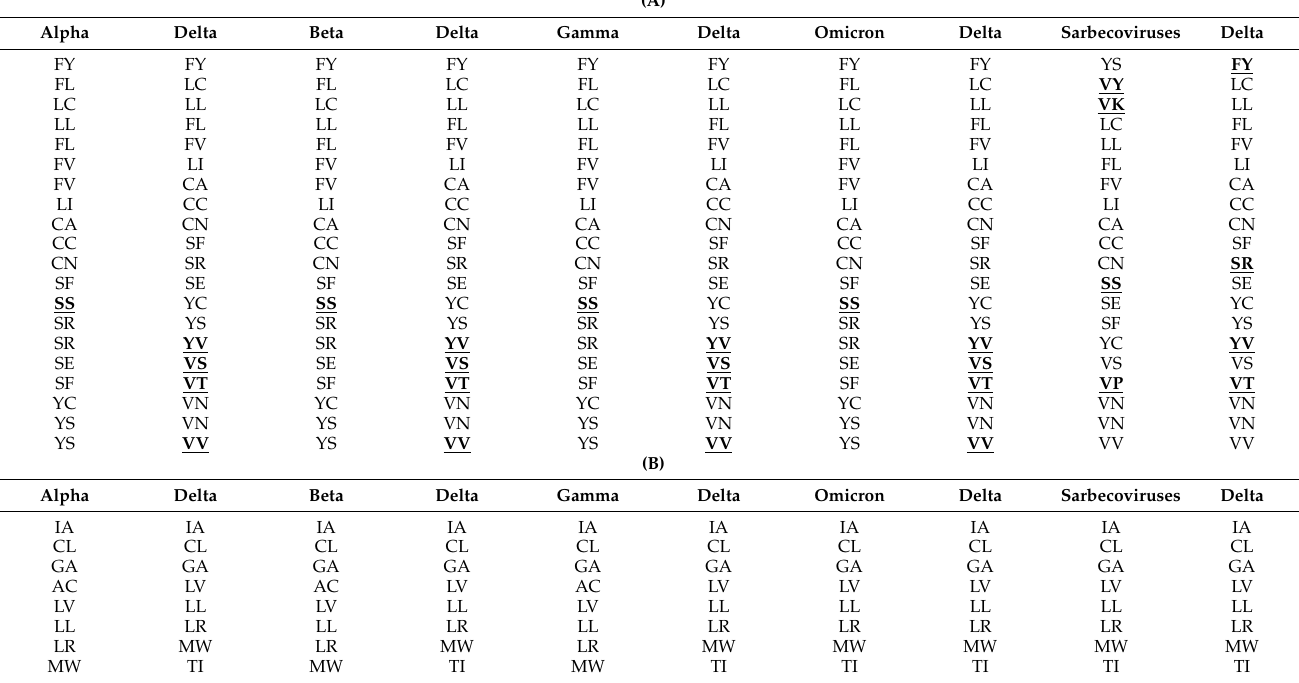
Table 5. (A) Comparison of the E gene of the delta strain with other strains. (B) Comparison of the M gene of the delta strain with other strains. (C) Comparison of the N gene of the delta strain with other strains. (D) Comparison of the S gene of the delta strain with other strains. Dissimilar preferred codon pairs are depicted in bold and underlined.